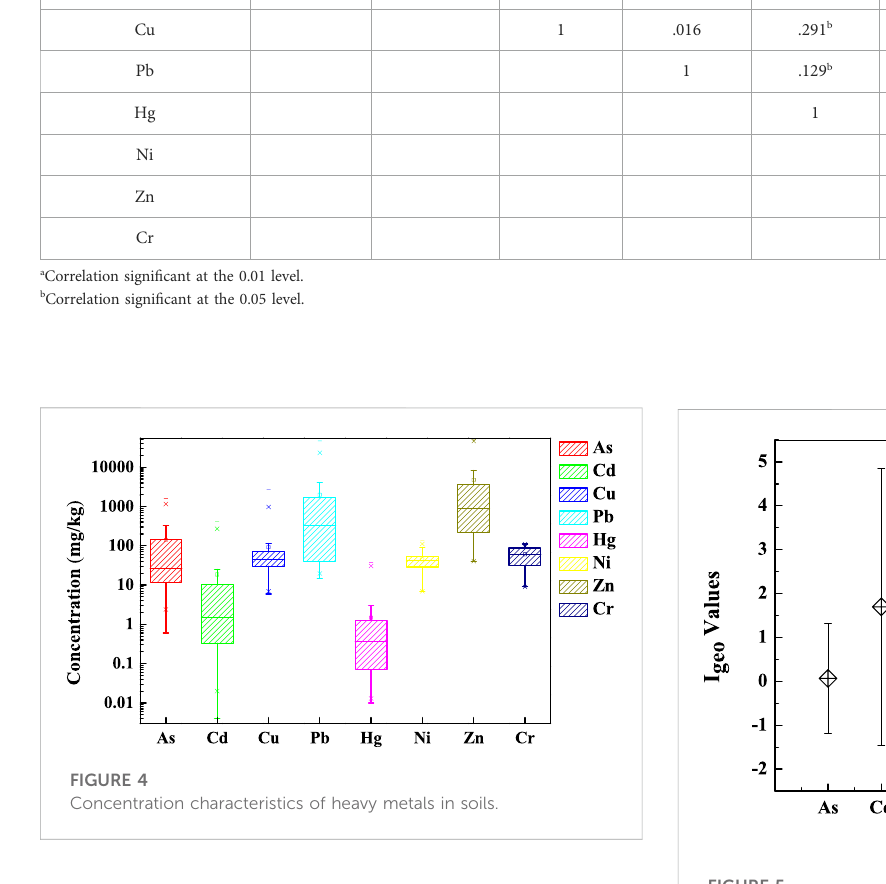
FIGURE 5 Average I geo values of heavy metals from